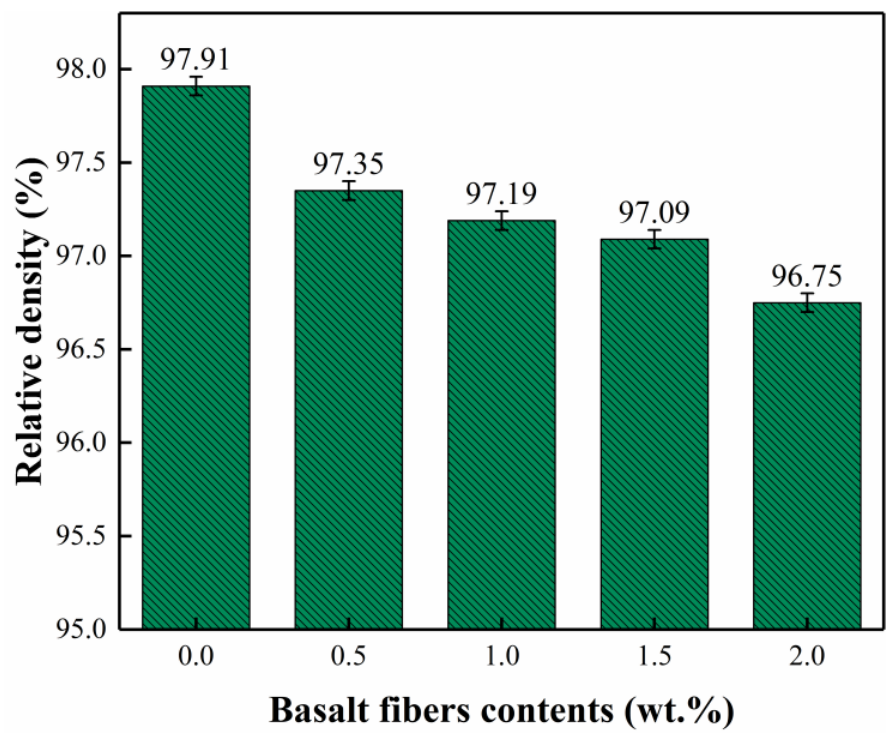
Figure 5. Relative density of copper-matrix composites.